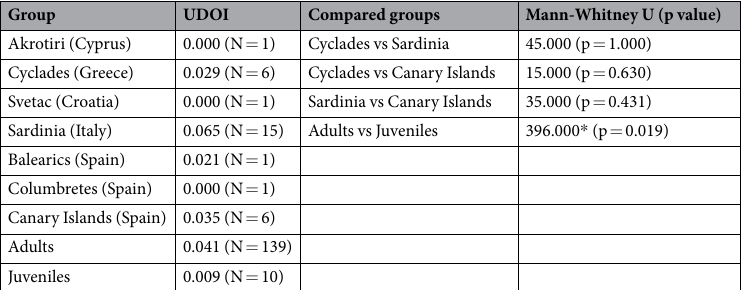
Table 1. Home range overlap analysis results based on 95% Kernel Density Estimation (KDE) of 23 Eleonora’s falcons overwintering in Madagascar analyzed using the Utilization Distribution Overlap Index (UDOI). Statistical significant differences are annotated with an asterisk ( * ). N denotes the number of inter-individual UDOI values averaged per colony and age class